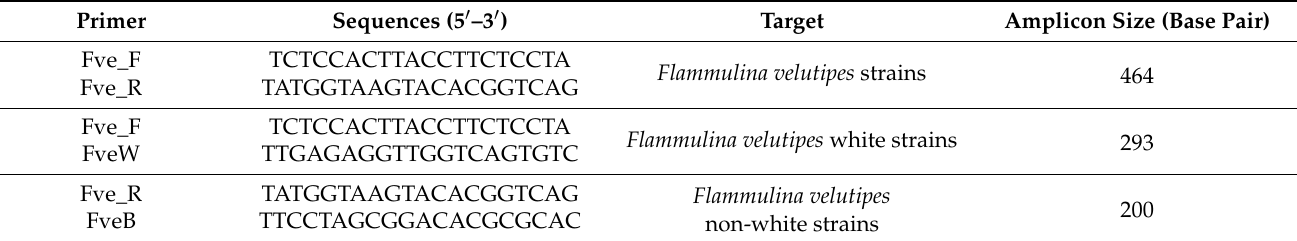
Table 2. Primers used in this